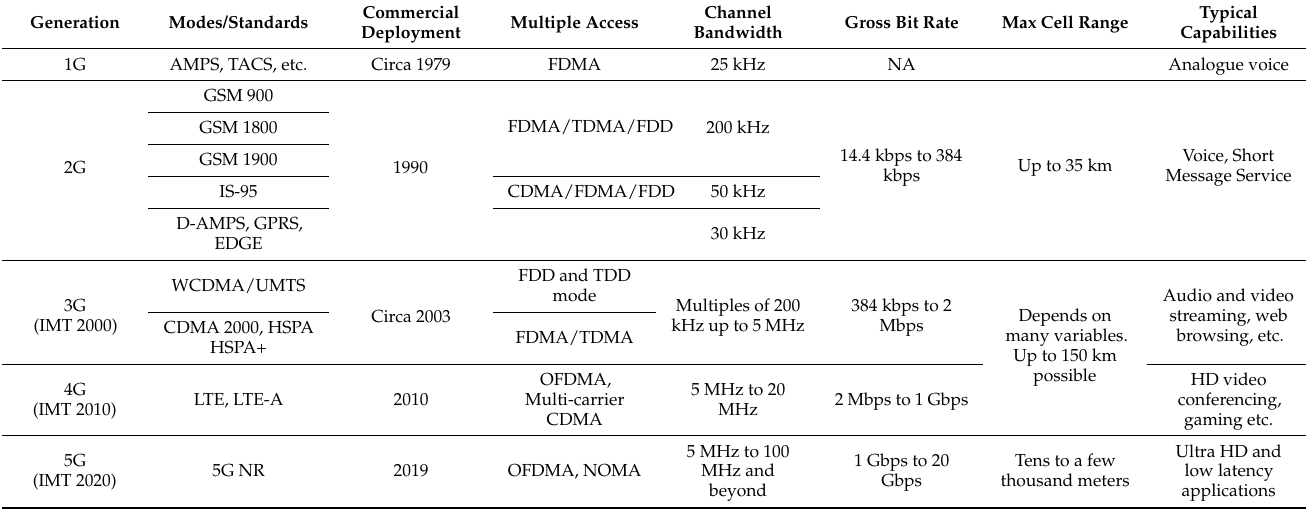
Table 1. Summary of mobile broadband